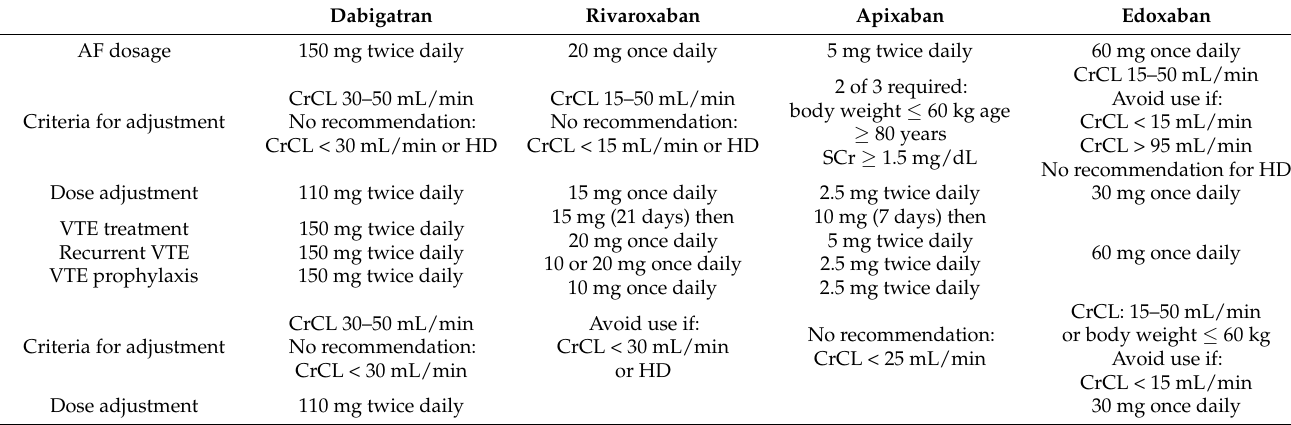
Table 3. Management of DOAC in atrial fibrillation (AF) and venous thromboembolism patients.